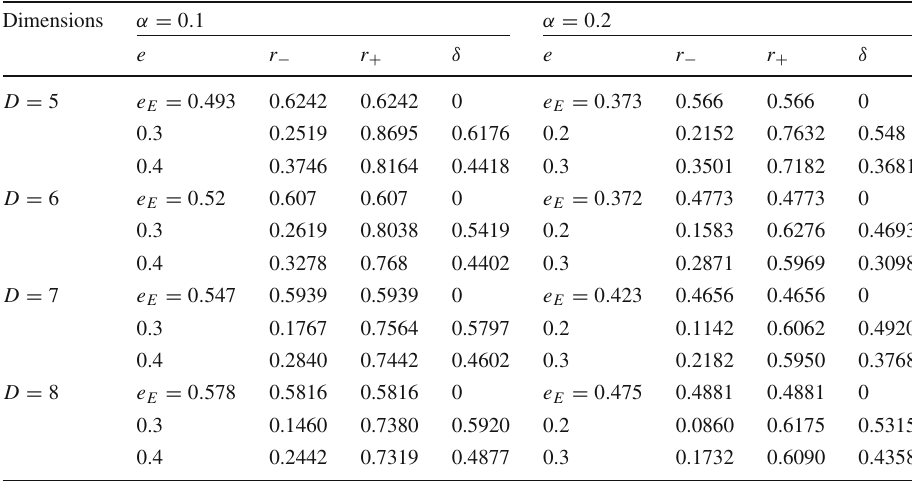
horizon ( r − ), the event horizon ( r + ) and δ = r + − r − for different values of charge e and dimension